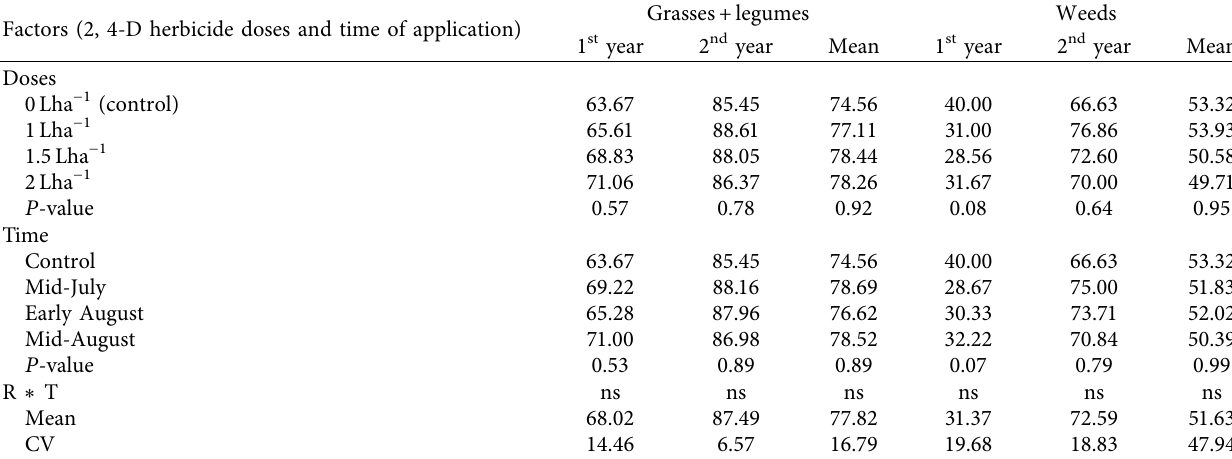
Grasses +legumes